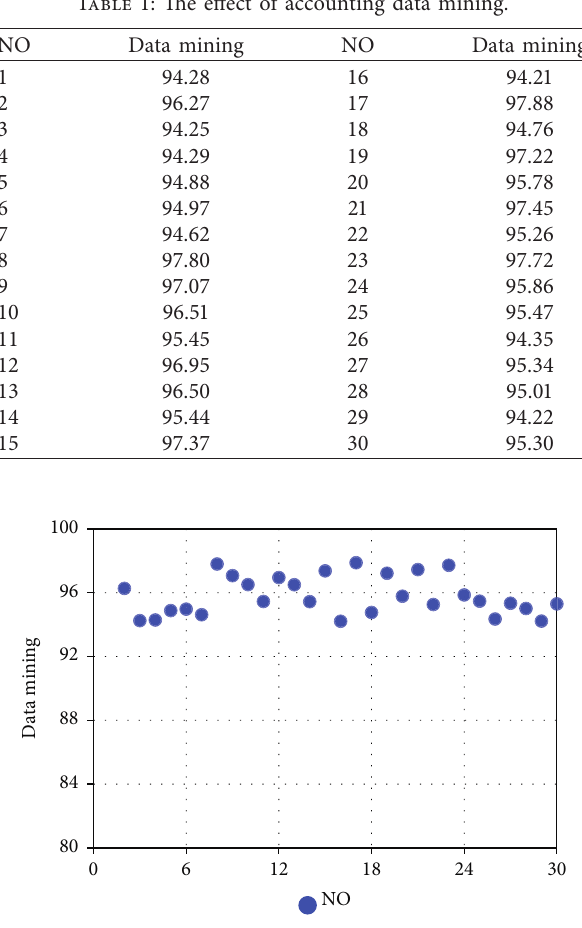
Figure 9: Statistical diagram of accounting data mining. Table 2: The effect of accounting data quality evaluation.